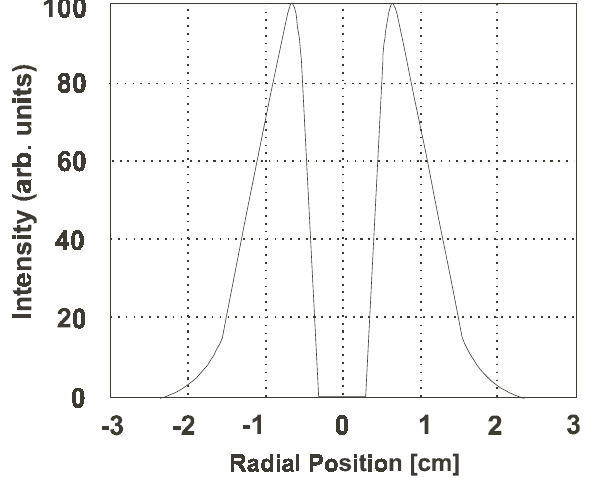
FIG. 2. Simulated annular-shaped radial distribution of the laser intensity after the axicon